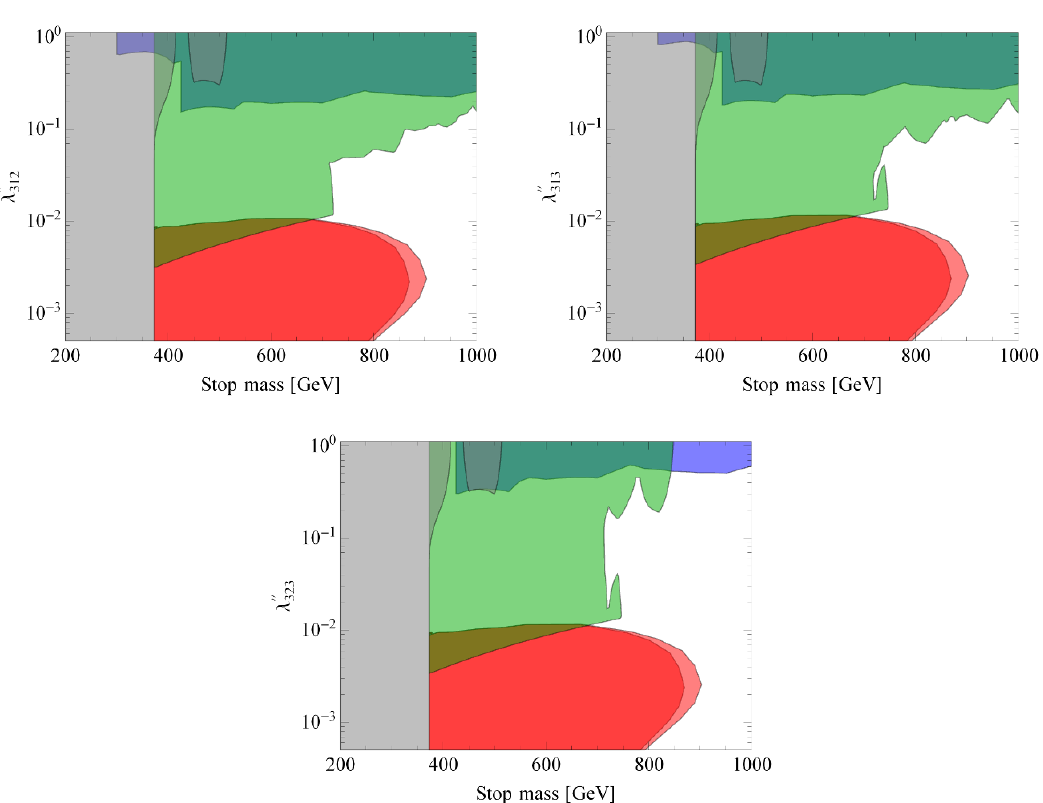
Figure 12. Exclusion plots for a 200 GeV bino neutralino LSP with the U(1) R symmetry broken. . 375 GeV) is excluded by paired dijet searches. The grey region on the left side of the plots ( m ~ t Next, consider the middle region of the plots. Starting from large (cid:21) 00 couplings and working 3 ij downwards, the blue region is excluded by dijet searches, the green region is excluded by neutralino LSP searches and the red regions are excluded by displaced vertices searches. Bino pair production, which contributes to the displaced vertices limits, depends on the masses of the (cid:12)rst and second generations of squarks. Setting the masses of these squarks to 10 TeV results in the darker red region being excluded. Instead, setting the masses of these squarks to 1 TeV excludes both the darker red and lighter red